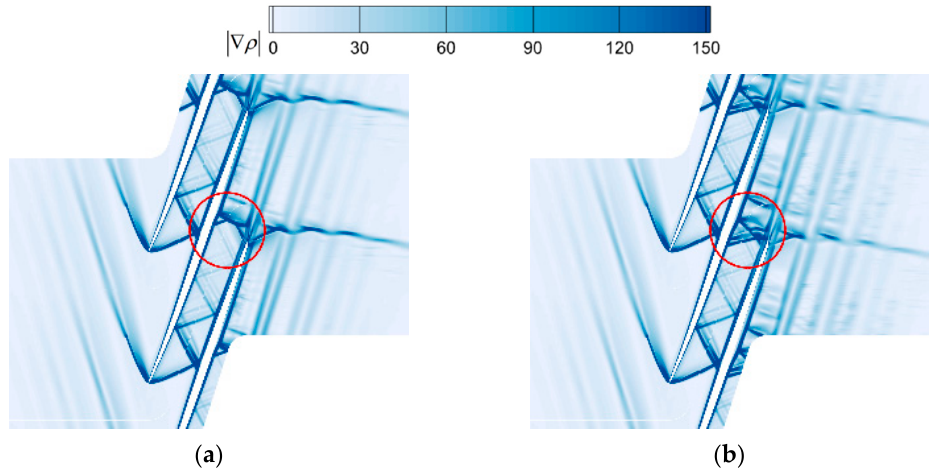
Figure 4. Density gradient magnitude contours for baseline and controlled cases: ( a ) baseline case; ( b ) controlled case.